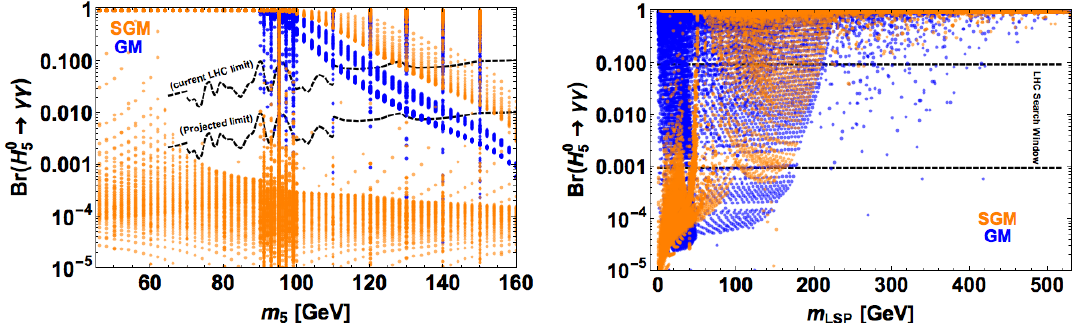
Figure 3 . Top: custodial (cid:12)veplet branching ratio into photons in the GM model (blue) and SGM model (orange) as a function of (cid:12)veplet mass. The current bounds from LHC diphoton data [37, 38] are shown (top dashed curve) as well as a rough future projection of sensitivity (lower dashed curve) assuming an order of magnitude improvement at a high luminosity LHC [81]. Bottom: same as top, but as a function of the LSP mass. The black dashed lines indicate a rough estimate of the potential LHC diphoton search